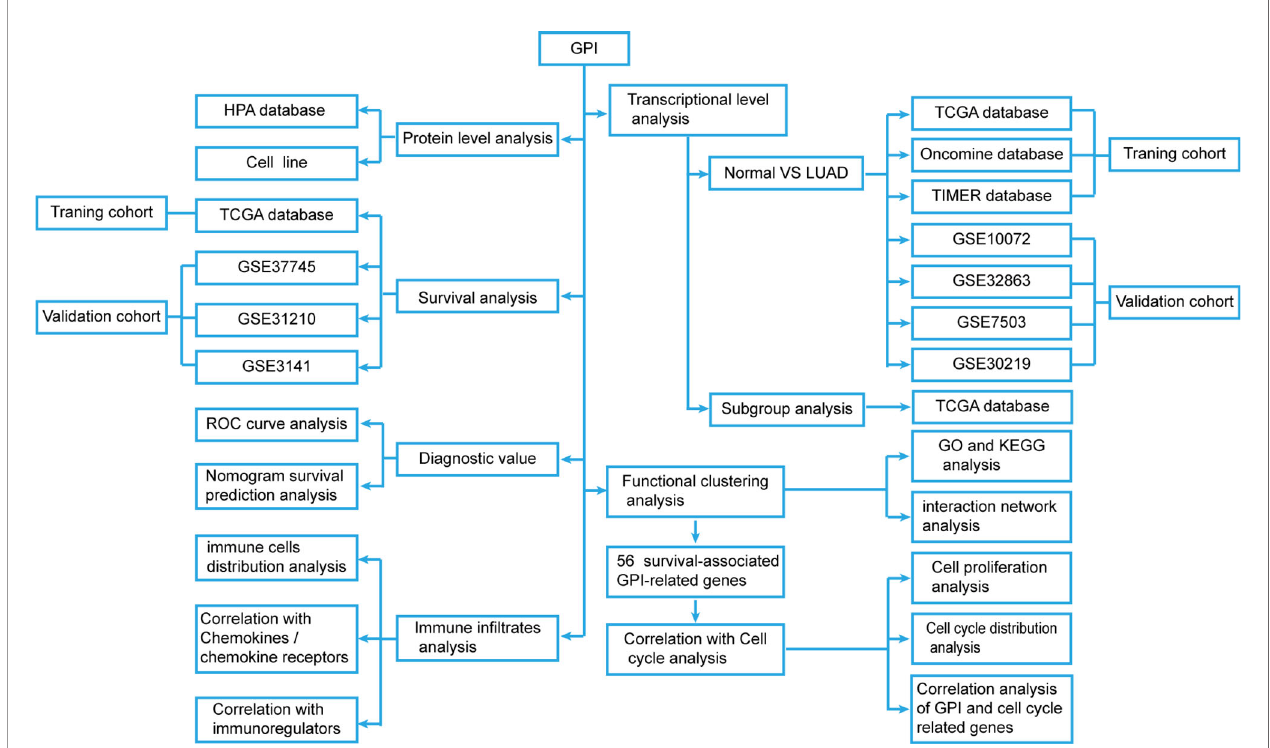
FIGURE 1 | Flow diagram of the data collection and method implementation in this